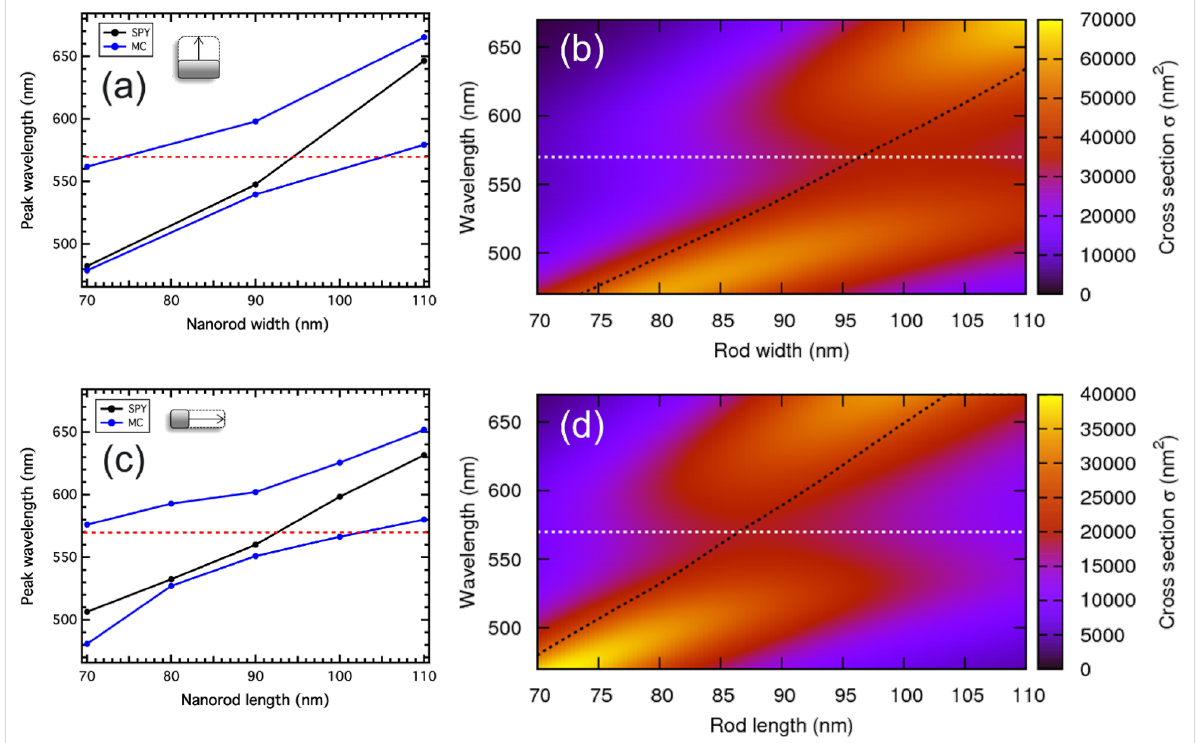
Figure 3: (a) Experimental spectral evolution of the transverse (90°) plasmonic peak as a function of the rod width for a fixed length of 110 nm. (b) Calculated extinction cross-section map for the corresponding ellipsoids as a function of the wavelength and the ellipsoid width. (c) Experimental spectral evolution of the longitudinal (0°) plasmonic peak as a function of the rod length for a fixed width of 70 nm. (d) Calculated extinction cross- section map for the corresponding ellipsoids as a function of the wavelength and the ellipsoid